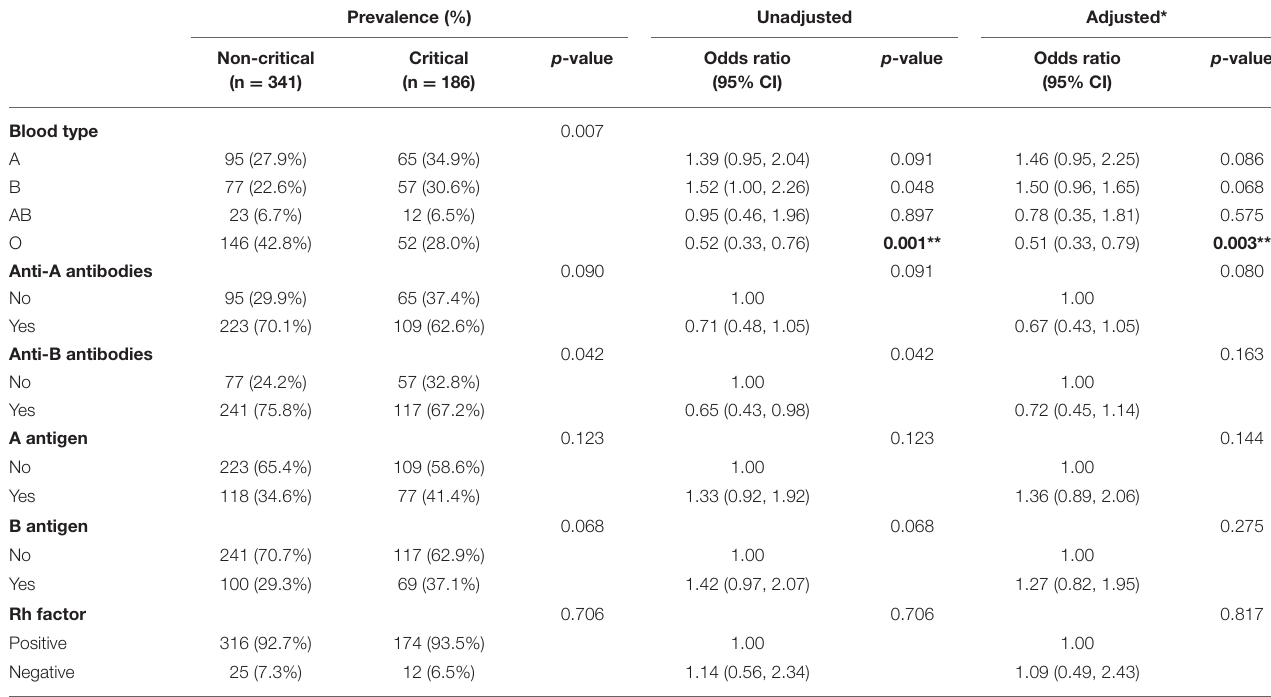
TABLE 2 | Association of blood type characteristics to noncritical vs. critical coronavirus disease 2019 (COVID-19) hospital